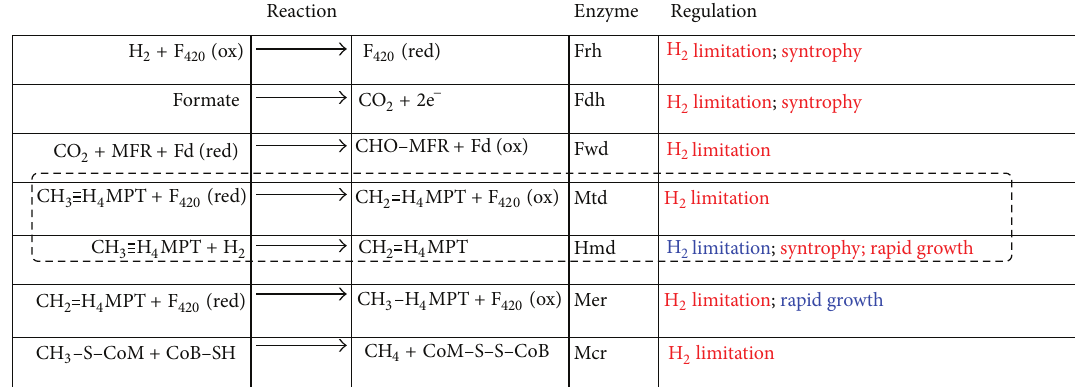
Figure 2: Observed regulatory patterns in hydrogenotrophic methanogenesis. Regulation steps for hydrogenotrophic methanogenesis are summarized from published sources discussed in this paper. Conditions, (syntrophic interaction or H 2 limitation) causing upregulation and downregulation of enzyme transcript levels are indicated in red and blue, respectively. Abbreviations are as per Figure 1 with the addition of the following: F 420 : coenzyme F 420 ; Fd: ferredoxin; Frh: F 420 -reducing hydrogenase; Fdh: formate dehydrogenase; Fwd: formyl- MFR dehydrogenase; Mtd: F 420 -dependent methylene-H 4 MPT dehydrogenase; Hmd: H 2 -dependent methylene-H 4 MPT dehydrogenase; Mer: F 420 -dependent methylene-H 4 MPT reductase; Mcr: methylcoenzyme M reductase. (The dotted lined box highlights two isofunctional enzymes oppositely regulated by H 2